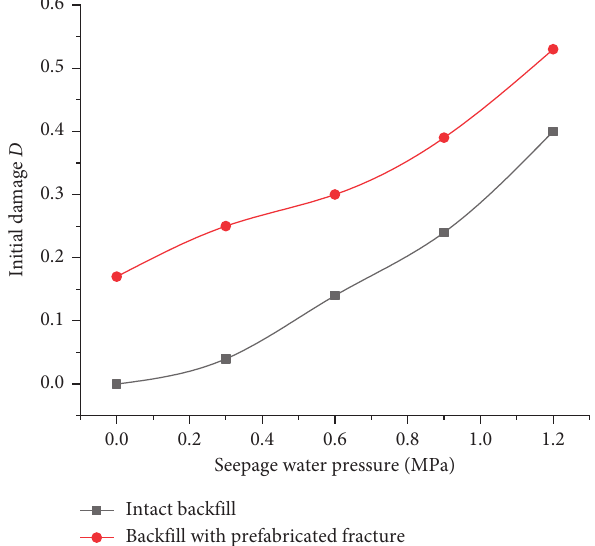
Figure 5: Relationship curves between initial damage and seepage water pressure.